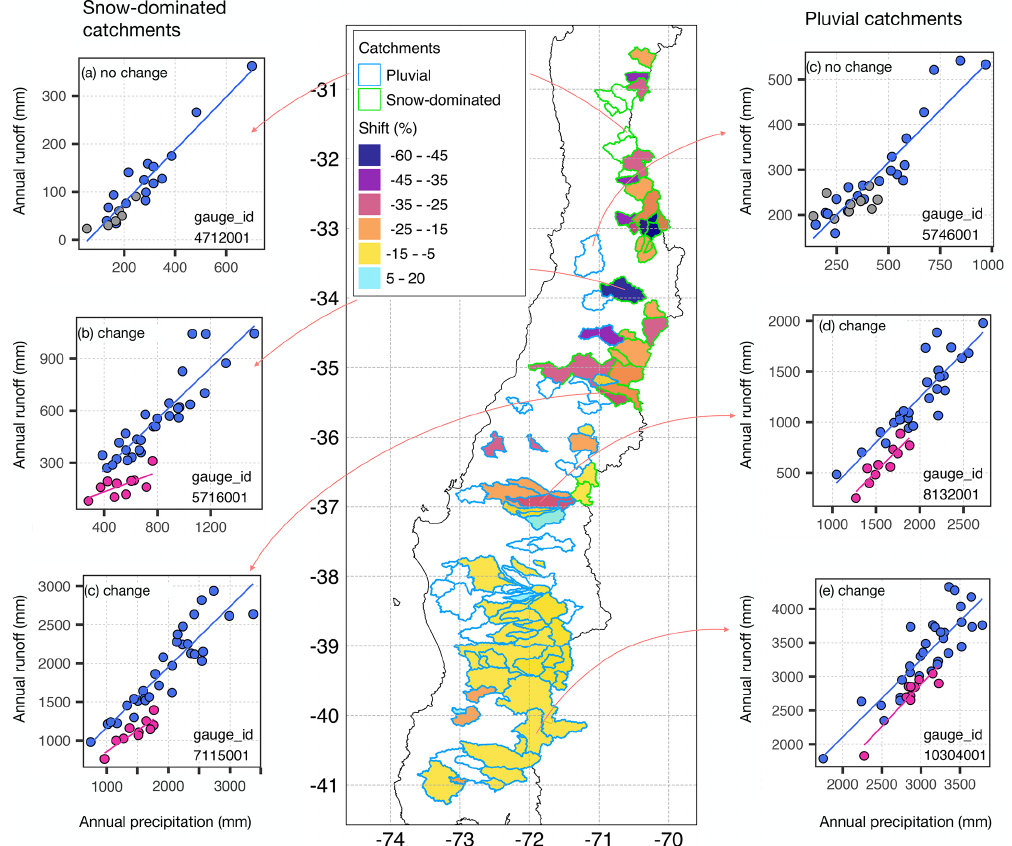
Figure 7. Annual runoff ( y axes) and precipitation ( x axes) for selected snow-dominated catchments with and without a significant change in P–R relationships during the MD (a–c) . Panels (d–f) show three selected pluvial basins with and without change. The years within the MD are highlighted in magenta when there was change and grey when there was no change in P–R regressions. The map shows the catchments with change coloured by their shift in P–R